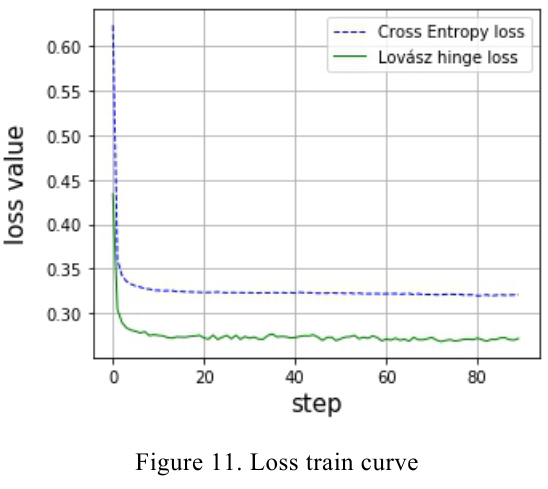
Figure 11. Loss train